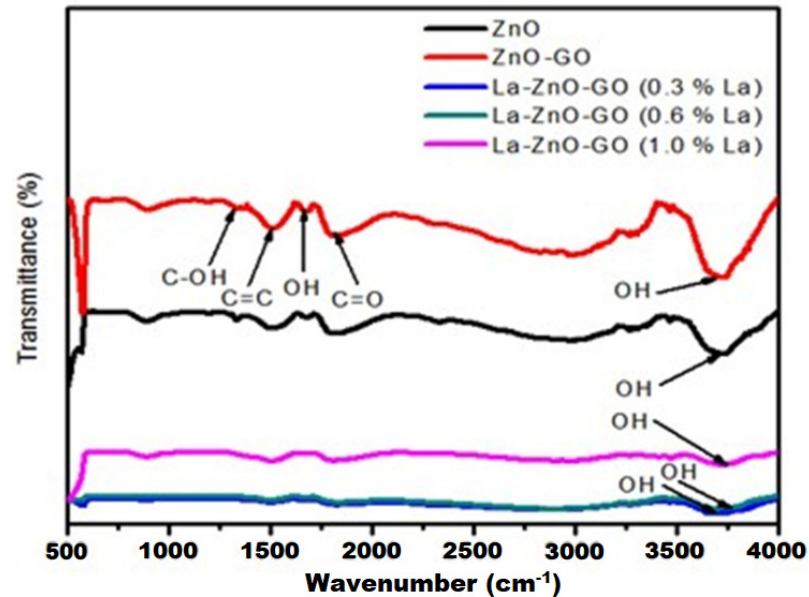
Figure 11. FT-IR spectra of La-doped-ZnO nanomaterials decorated on graphene oxide [75]. Furthermore, Raman analysis of the ZnO, ZnO/GO, and 0.3% La/ZnO/GO revealed the presence of strong peaks of ZnO at 331, 442, and 589 cm − 1, which arose due to defects in the ZnO/GO via oxygen vacancy as shown by the D band defects observed around 1350 cm − 1 in Figure 12. The optical response of the ZnO changed due to its modification with La and graphene oxide (Figure 12a). ). In addition, the G bands originate from the in-plane tangential stretching of the carbon–carbon bonds in the graphene structure (Figure 12b Compared to pure ZnO, the combined impact of the graphene oxide and La improved the Vis absorption. This strategic doping with La/GO decreased the band-gap energy level due to the modification of the ZnO conduction band, resulting in the Vis absorption. Apart from being a sensitiser (absorbing Vis), graphene oxide acted as an electron collector by creating a new energy level in the band gap, allowing photoinduced electrons from this energy level into the conduction band of ZnO. The ultra-violet-diffuse reflectance (UV-DRS spectra are shown in Figure 13a, while the band gap of the materials was estimated using the Kubelka–Munk function ( F ( R )), presented in Figure 13b. Srinivasan et al. [98] reported on the influence of carbon doping and modification with BiVO 4 on the properties of ZnO nanomaterials. The optical profile of the synthesised materials was studied by ultra-violet-diffuse reflectance (UV-DRS) and photoluminescence (PL) spectroscopies. They reported that the absorption band gap edge of C-ZnO had shifted to 412 nm (due to the embedded carbon) compared to the absorption edge of pure ZnO recorded at 396 nm, (Figure